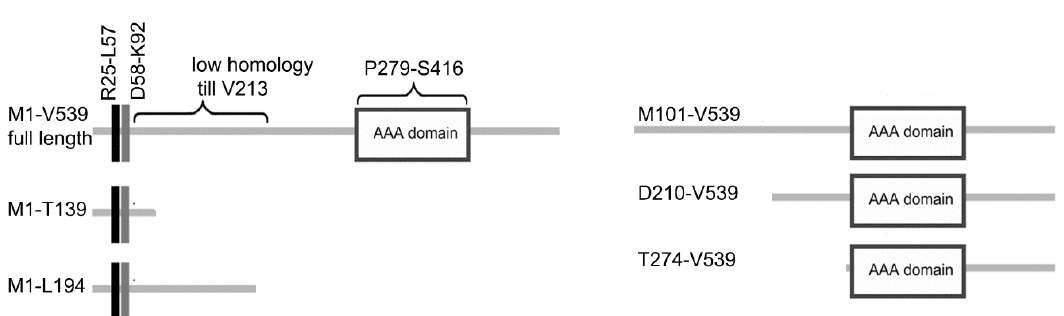
Figure 4. A graphical representation of the Kat2 domain organization and analyzed truncated variants. The black rectangle represents the LisH domain and the grey rectangle marks the position of the adjacent CTLH, whilst the white rectangle indicates the position of the AAA domain.